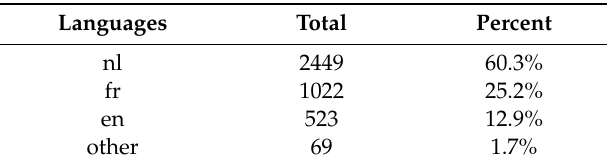
Table A3. Primary languages (be).